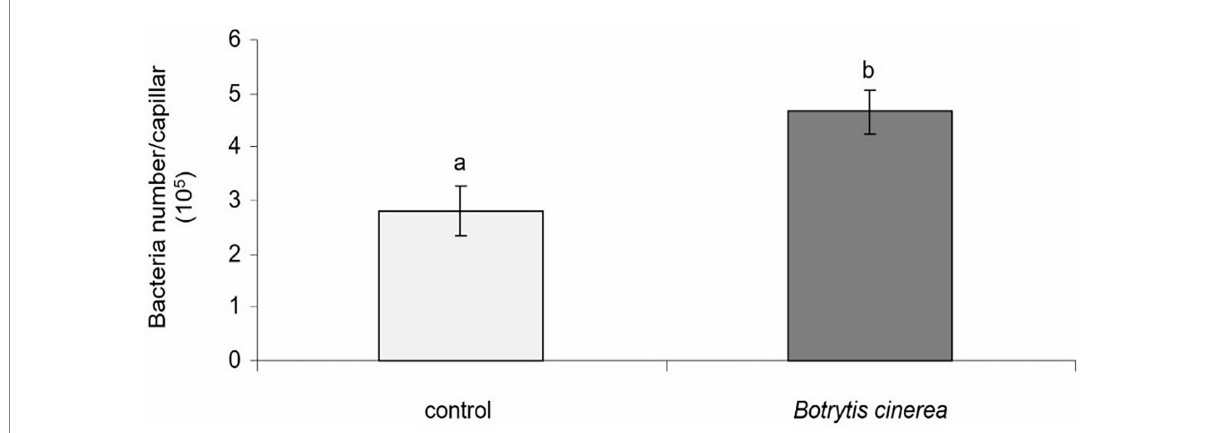
FIGURE 6 Resistance induced by P. phytofirmans PsJN against Botrytis cinerea . (A) Detection of B. cinerea in planta by qPCR using primers targeting the Actin encoding gene, at 24 and 72 hpi. (B) Symptoms developed on inflorescences bacterized or not at 96 hpi with B. cinerea .